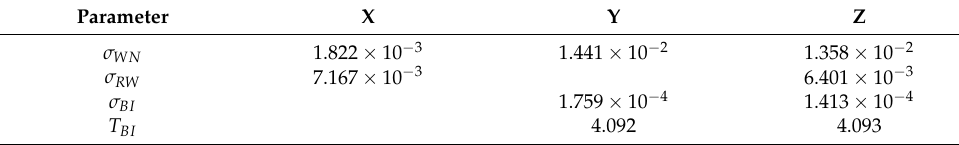
Table 3. The parameter estimation results of EM-based method.